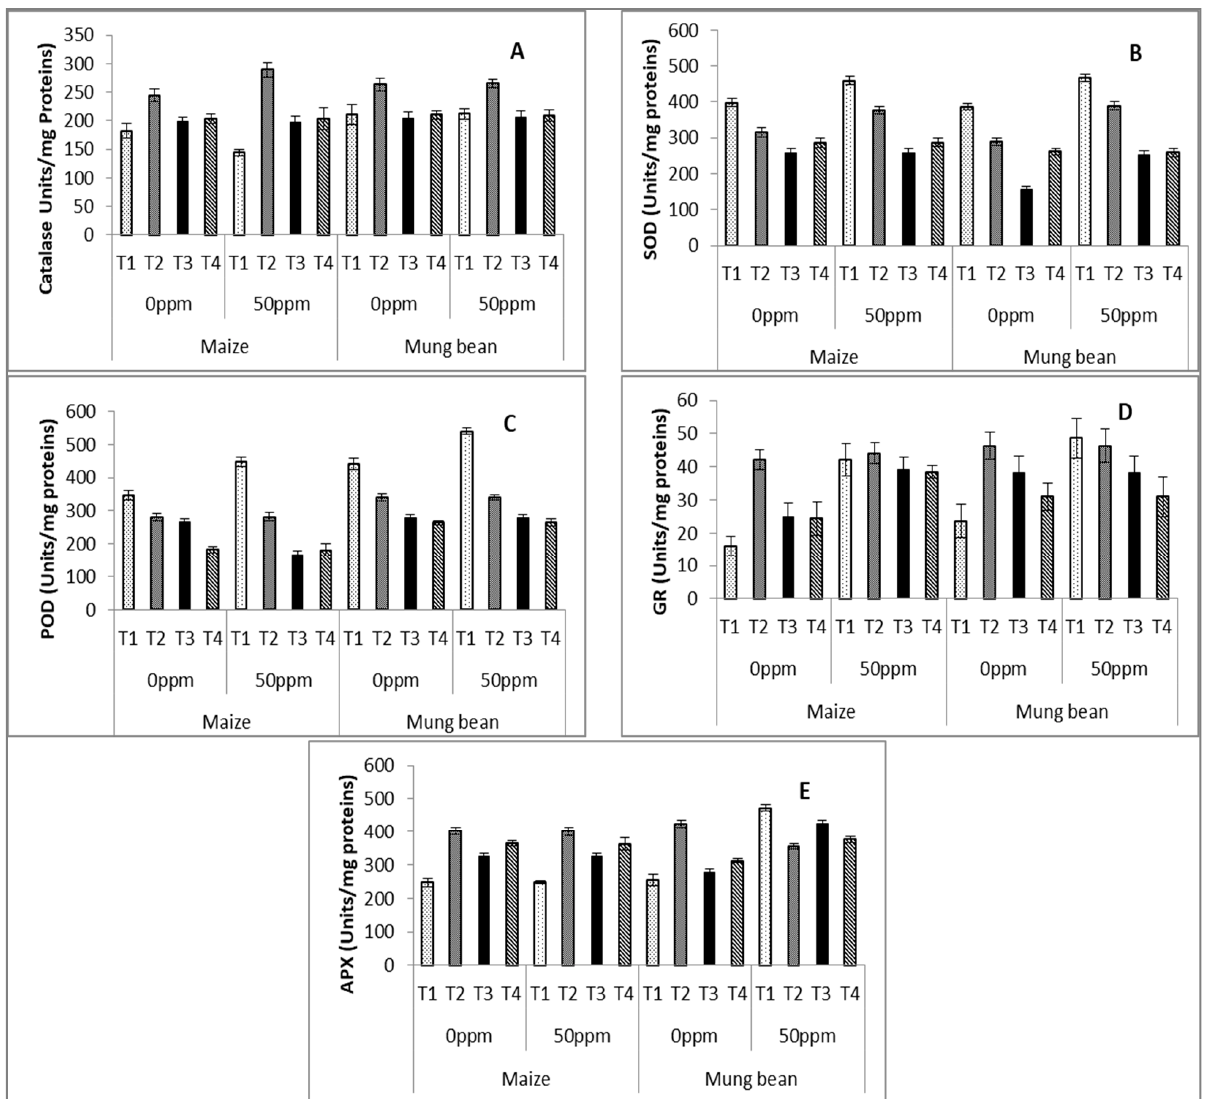
Figure 3. Estimation of activities of ( A ) superoxide dismutase (T1), ( B ) catalase (CAT), ( C ) peroxidase (POD), ( D ) glutathione reductase (GR) and ( E ) ascorbate oxidase (APX) enzymes of maize ( Zea mays L.) and mung bean ( Vigna radiata L.) exogenously treated with Bacillus subtilis under chromium stress conditions (mean ± S.E.). Here, T1 = Nutrient broth, T2 = Nutrient broth + parent B. subtilis , T3 = Nutrient broth + UV-irradiated B. subtilis and T4 = Nutrient broth + γ -irradiated B. subtilis .